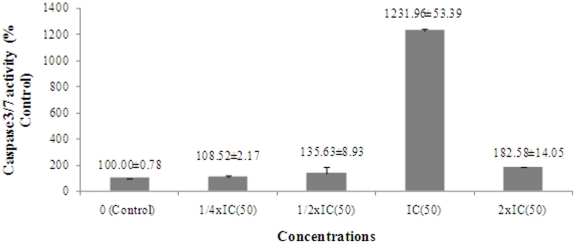
Enzymatic activity of caspase 3/7 after 6 h treatment of CCRF-CEM cells with compounds 1.The activity of caspase 3/7 is expressed as percentage % relative to untreated cells. Compound 2 did not show any induction of caspase 3/7 activity (data not shown). Values are mean ± SD of three duplicated experiments.